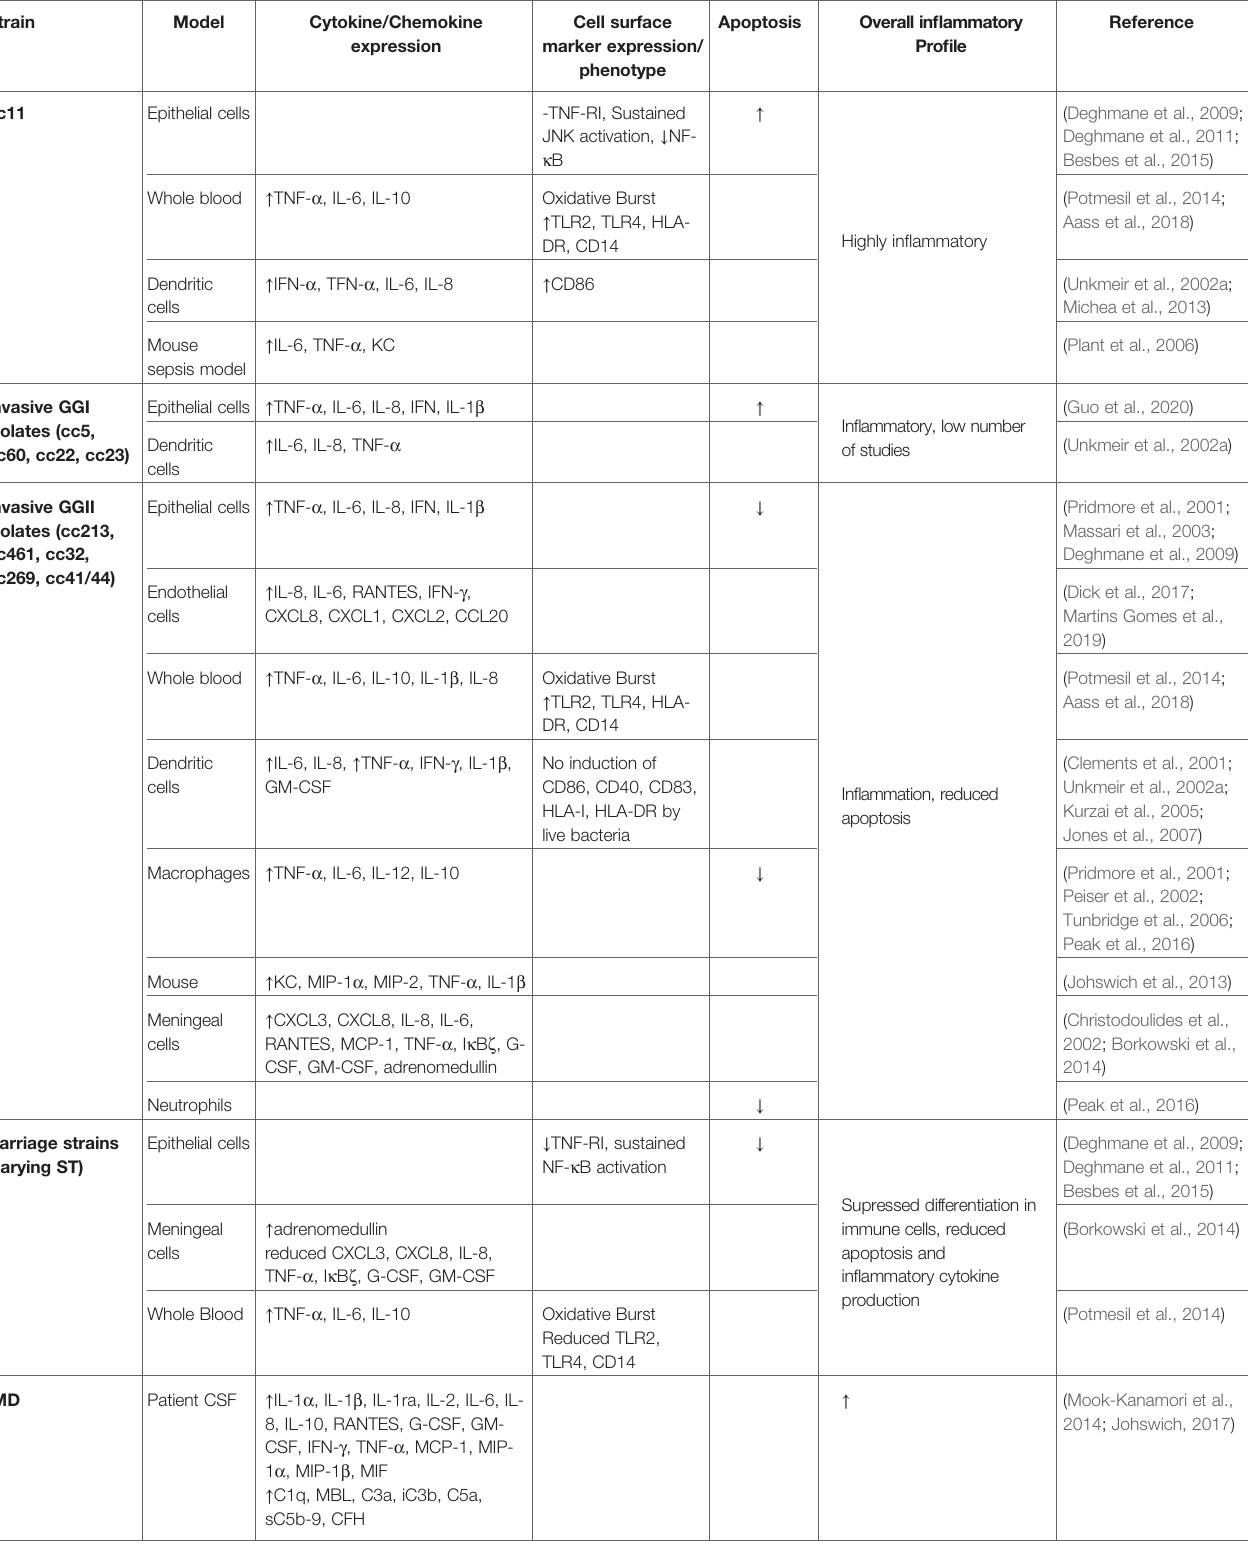
TABLE 1 | In fl ammation and immune modulation caused by N. meningitidis from different lineages.